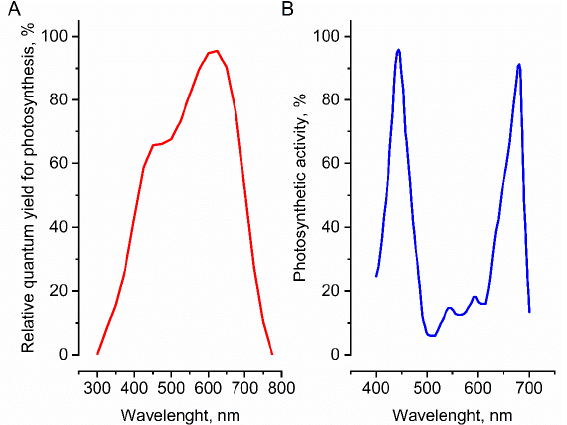
Figure 1. ( A ) Relative quantum yield for photosynthesis (adopted from [4]). ( B ) Action spectrum of photosynthesis calculated on a photon basis (adopted from [5]). I t is well known that up to 80% of the energy used in photosynthesis is provided by photons with a wavelength of about 650 nm. Despite the fact that red light (601 – 700 nm) determines the efficiency of photosynthetic processes and also accelerates the transition of a plant to flowering [6,7], the growth and development of plants depends on the spectral composition of the light. For example, blue (441 – 500 nm) and violet light (401 – 440 nm) are involved in the regulation of chlorophyll synthesis, chloroplast development, and photo- morphogenesis, induce secondary metabolisms due to cryptochrome and phytochrome , and also regulate stomata opening [8 – 10]. An increase in the proportion of blue light under high light conditions leads to the accumulation of PsbS and LHCSR3 proteins in higher plants and algae, respectively, which are heat dissipation effectors [8]. Green (501 – 565 nm) light is absorbed by various carotenoids and chlorophylls in the deep layers of the leaf. In nature, yellow (566 – 600 nm) and green light is important mainly for shade-tolerant and some aquatic plants [11]. Several studies have shown that light in the range from 501 nm to 600 nm has a significant effect on the physiology, morphology, and photosynthetic activity of plants [12 – 17]. Far-red radiation (701 – 800 nm) accelerates photosynthesis by balancing the stoichiometry of electron transfer in the photosynthetic electron transport chain (PETC), which increases the overall efficiency of photosynthesis, since excess blue and red light can cause PETC overreduction [1,18 – 21]. This process may involve specialized chlorophyll, which absorbs light in the far-red range and is associated with photosystem I [20]. It is known that a change in the red/far-red ratio can lead to the activation of the phytochrome system, which, in turn, can intensify photosynthesis, increase stress resistance, and acceler- ate plant growth [22 – 24]. From one to two percent of the solar energy reaching the Earth ’ s surface is ultraviolet radiation (UV) (280 – 400). UV-A (316 – 400), on the one hand, is one of the factors of photoinhibition [25], and on the other hand, UV-A stimulates an increase in the accumulation of secondary metabolites: phenols, flavonoids, anthocyanin, and ascorbic acid [26]. UV-B (290 – 315) has traditionally been considered a stressor. It can cause damage to the integrity and function of important macromolecules (DNA, proteins and lipids),